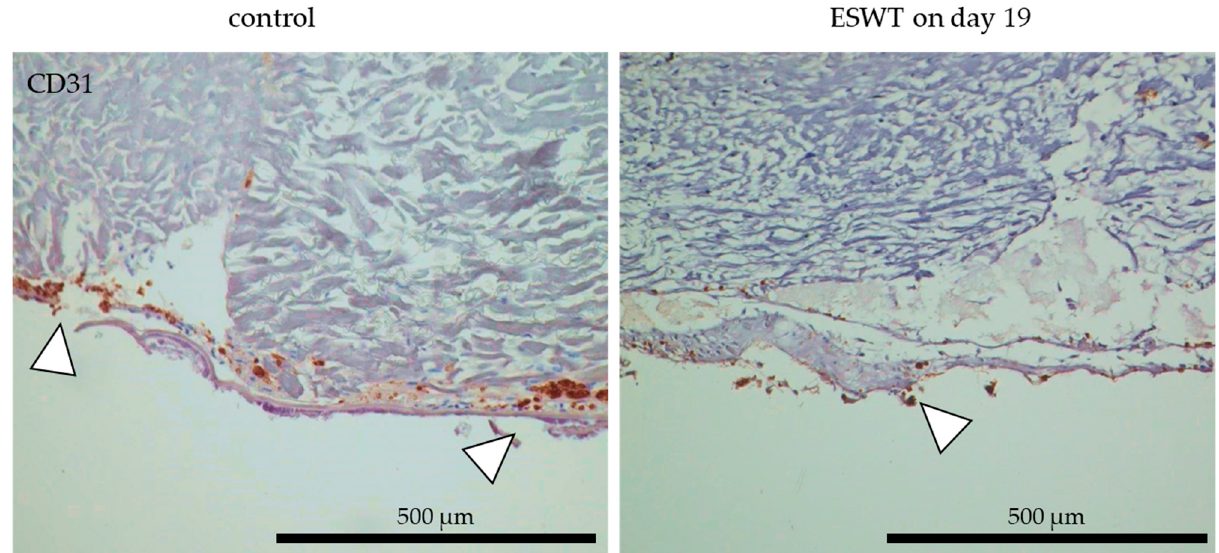
Figure 10. Localization of human microvascular endothelial cells in oral mucosa equivalents in ovo after ESWT in vitro. Oral mucosa equivalents were ESWT-treated on in vitro culture day 19 and transferred to the chorioallantoic membrane (CAM) on culture day 33. Untreated tissue equivalents on CAM served as the control. Endothelial cells were examined by CD31 staining (white arrows) with immunohistochemistry. In the images, the cell occlusive side of the collagen matrix is directed upwards and porous side directed downwards. Scale bars represent 500 μ m.